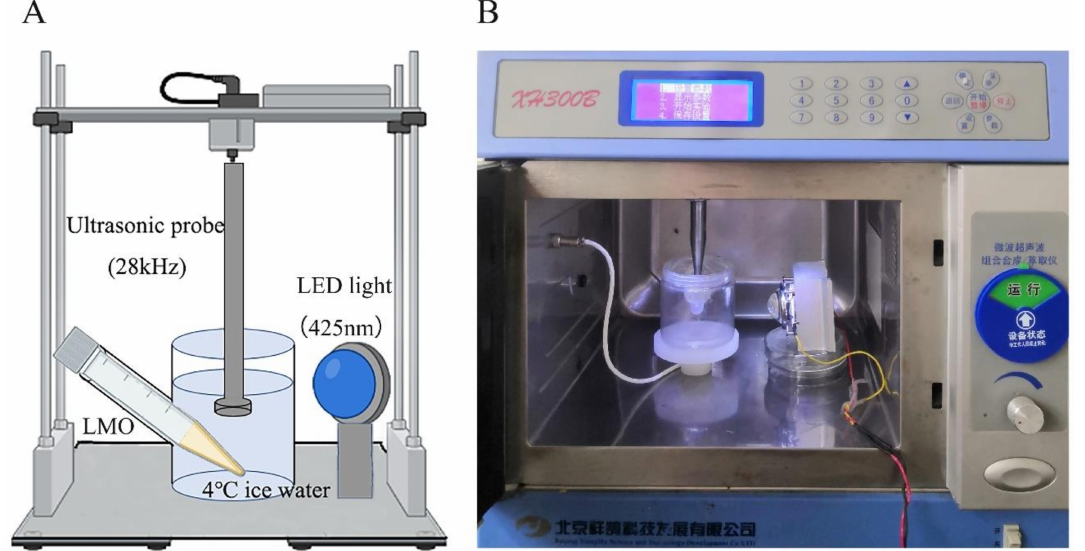
Figure 1. The schematic diagram ( A ) and apparatus ( B ) of sono-photodynamic treatment for inacti- vating food-borne bacteria Listeria monocytogenes